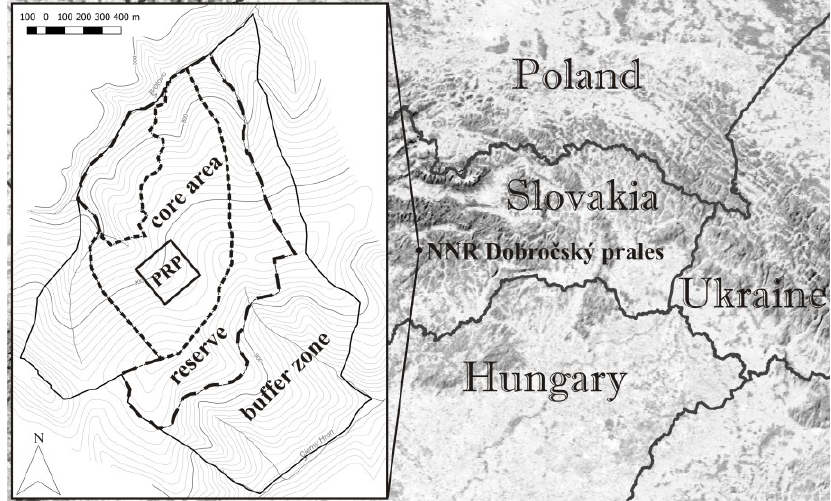
Figure 1. Location of National Nature Reserve Dobročský prales and layout of a permanent research plot.